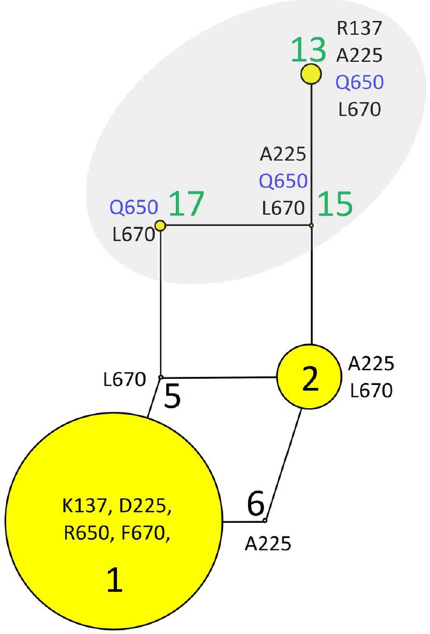
Figure 2. Maximum parsimony tree of polypeptide haplotypes encoded by TLR2 in the 102 case–control pairs of Turkish ewes. The areas of the circles are proportional to the variant frequency in the 102 matched pairs of ewes. The grey shaded area encompassed Q650 isoforms in Turkish sheep. Loop structures indicate recombination of haplotypes within populations.